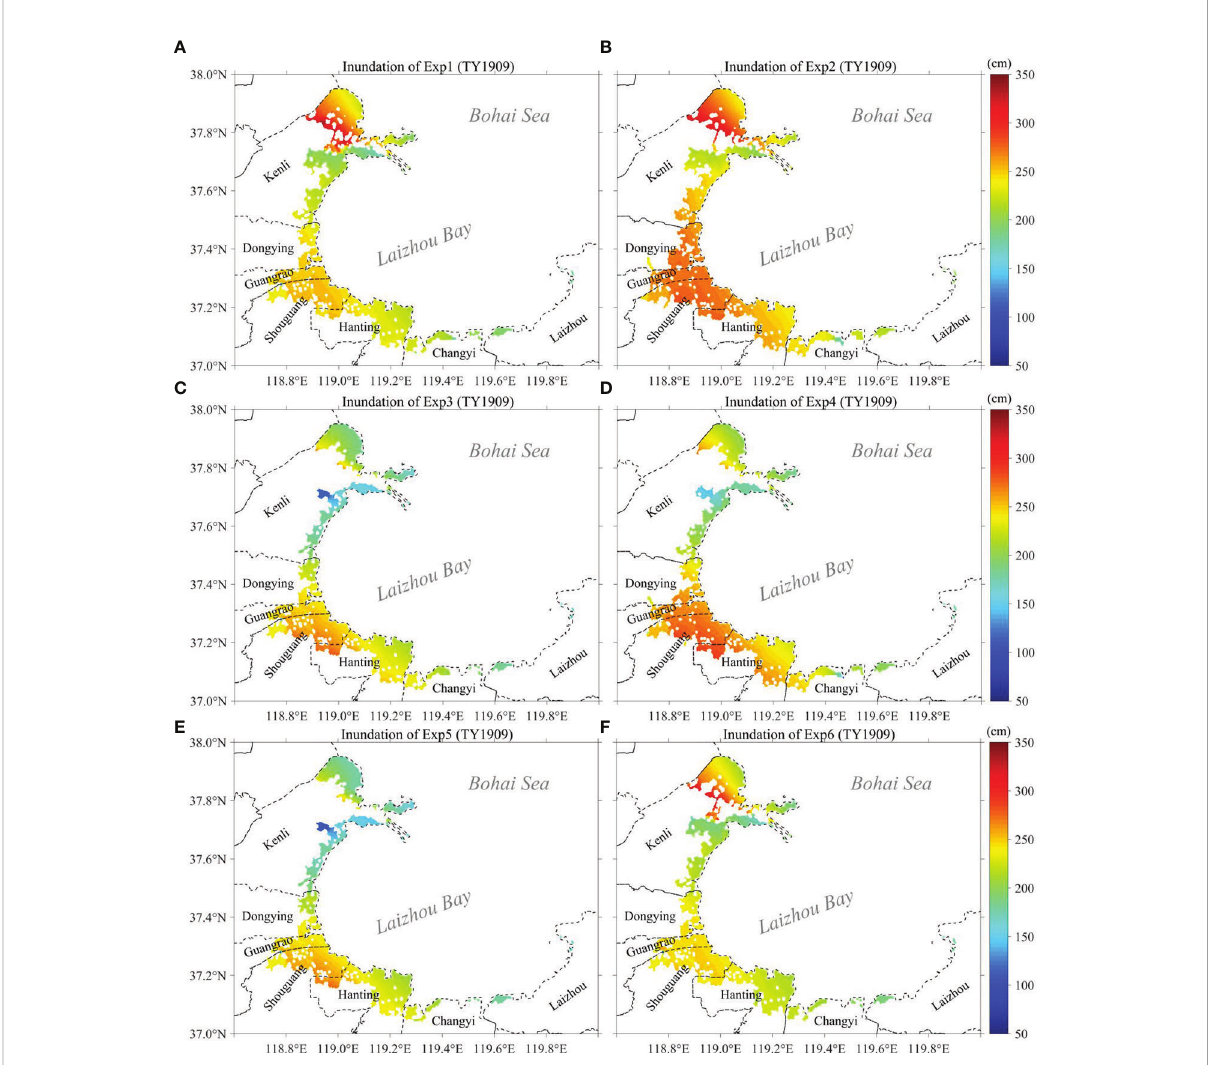
FIGURE 7 Inundation distributions and inundation depth (unit: cm) of TY1909 under Exp1 (A) , Exp2 (B) , Exp3 (C) , Exp4 (D) , Exp5 (E) , and Exp6 (F) along the LZB.